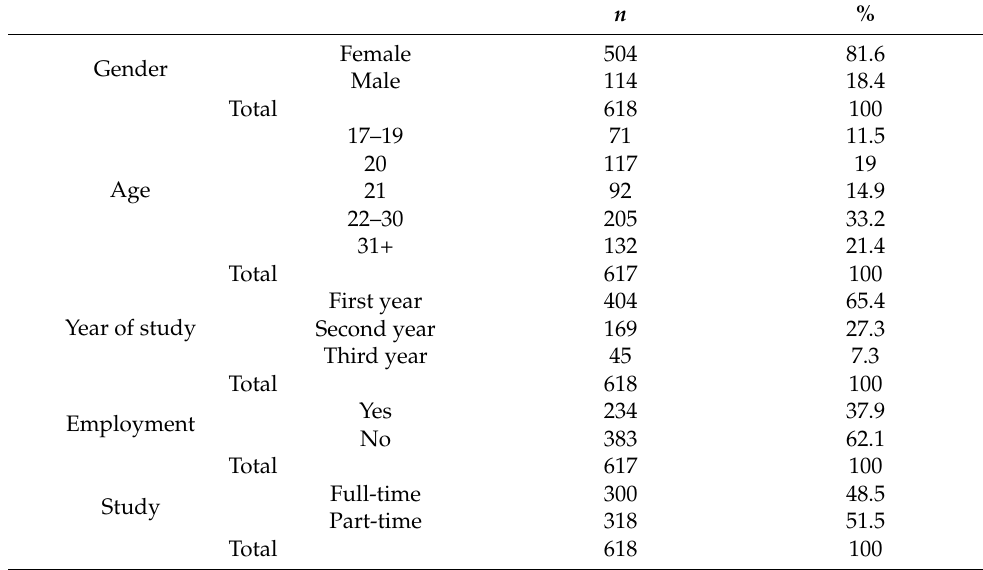
Table 1. Respondents’ demographic data.